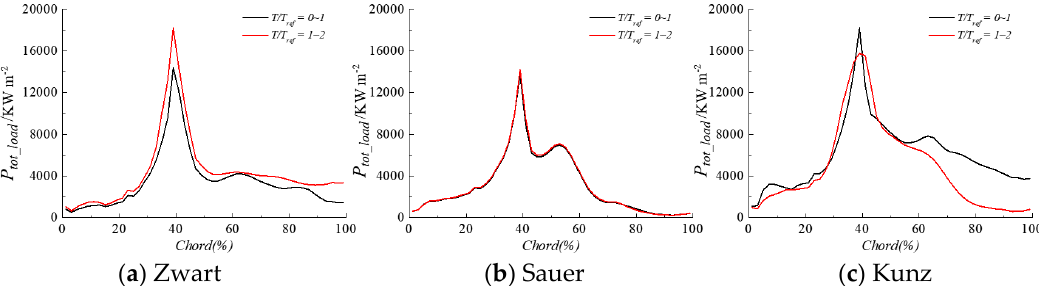
Figure 12. Comparison of P tot_load distribution obtained for the first (black line) and second (red line) shedding cycles with the different cavitation models.